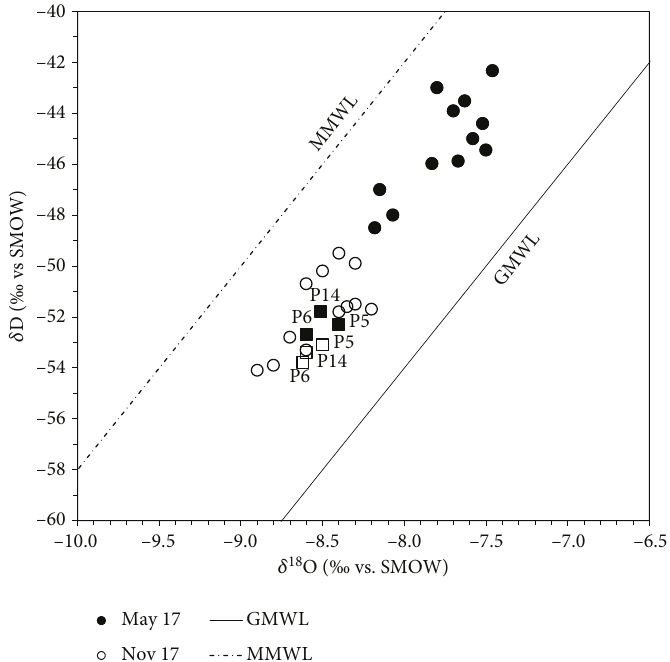
Figure 10: δ 18 O and δ D plot of local groundwater. For comparison, the global meteoric water line (GMWL) and the Mediterranean meteoric water line (MMWL) have been drawn. The fi lled and empty squares indicate the isotopic data of P6, P14, and P5 springs sampled in May 2017 and November 2017,